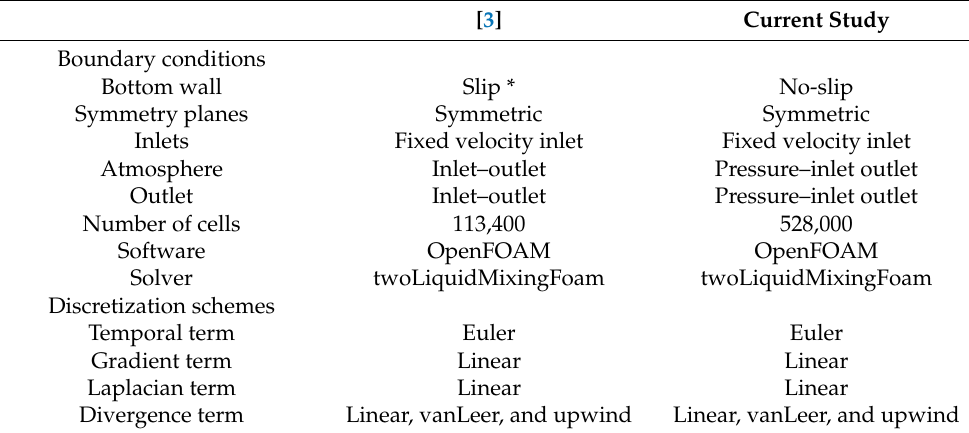
Table 2. Simulation characteristics of the previous [3] and present